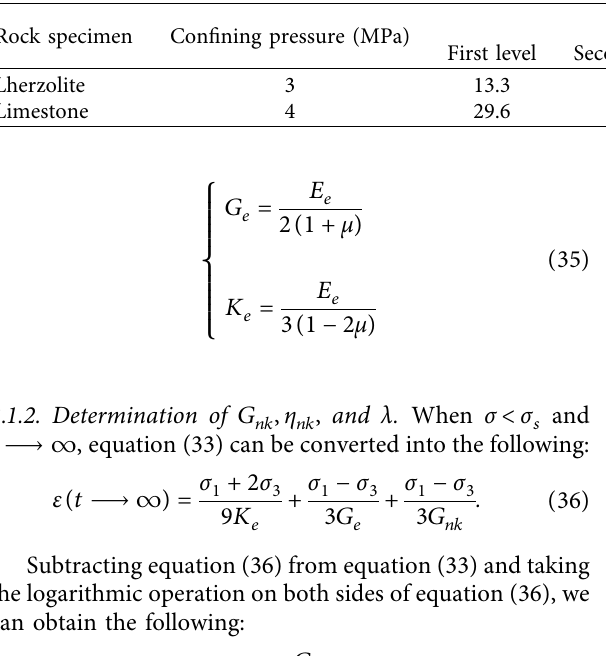
Table 2: Test scheme for triaxial